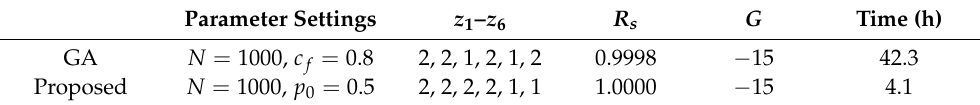
Table 6. Optimal solutions for the application